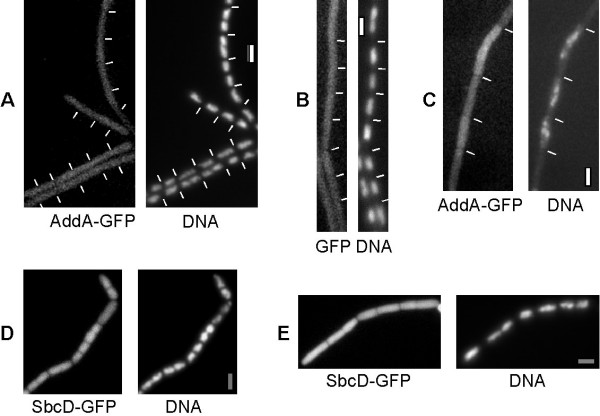
Fluorescence microscopy of Bacillus subtilis cells. A-C) Strain JN7 (addA-gfp) growing exponentially (A), or B) 30 min or C) 120 min after addition of 50 ng/ml MMC, D-E) strain JN4 (sbcD-gfp) growing exponentially (D), or 60 min after addition of MMC (E). White bars 2 μm.